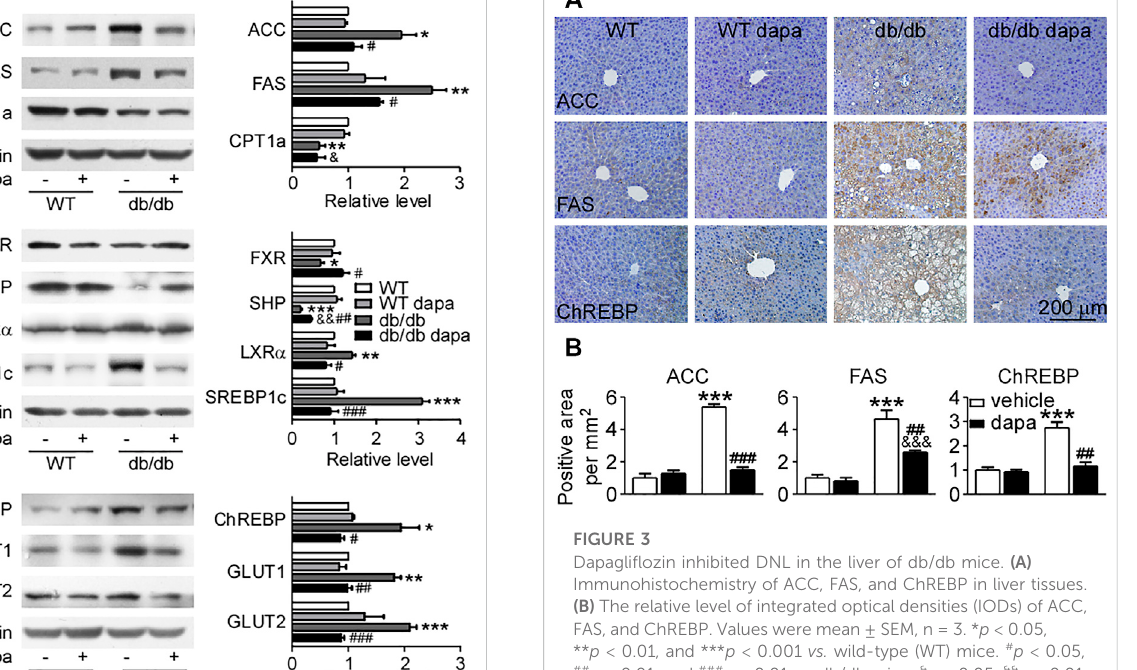
FIGURE 2 Dapagli fl ozin improved hepatic fat metabolism in db/db mice. (A) Representative western blotting ( left ) and quanti fi cation of protein levels ( right ) of fat acid metabolism-related proteins. (B) Representative western blotting ( left ) and quanti fi cation of protein levels ( right ) of SREBP-1c pathway-related proteins of livers. (C) Representative western blotting ( left ) and quanti fi cation of protein levels ( right ) of ChREBP, GLUT1, and GLUT2 of livers. Values were means ± SEM, n = 3. * p < 0.05, ** p < 0.01, and *** p < 0.001 vs. wild-type mice (WT). # p < 0.05, ## p < 0.01, and ### p < 0.001 vs. db/db mice. & p < 0.05 and && p < 0.01 vs. dapagli fl ozin- treated wild-type mice. One-way ANOVA, Bonferroni ’ s multiple